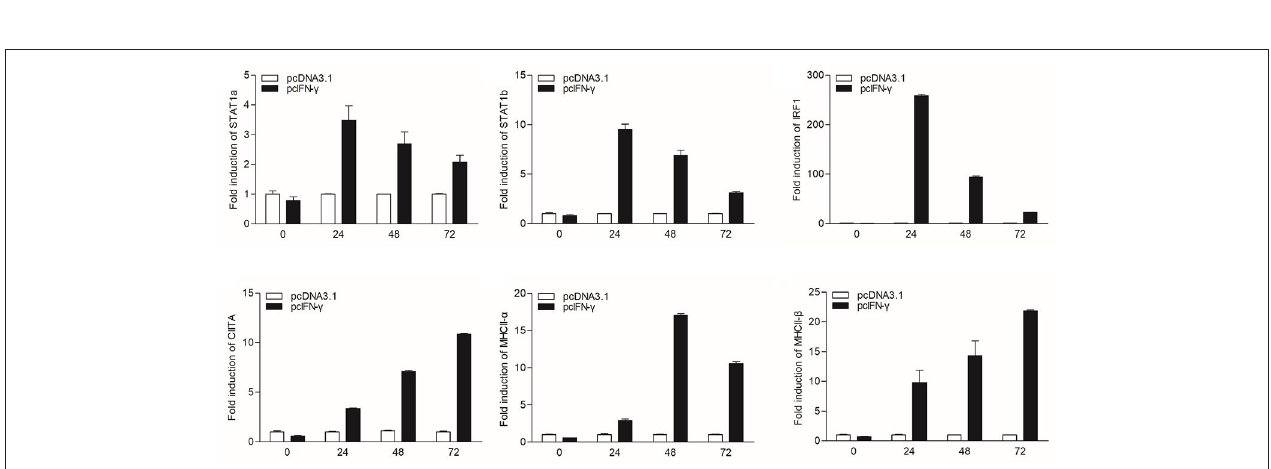
FIGURE 3 | mRNA expression of the STAT1a, STAT1b, IRF1, CIITA, and MHC II in vitro triggered by IFN- γ . GCO cells were transfected with 1.5 µ g pcDNA3.1 or pcIFN- γ respectively. Cells were harvested at 0, 24, 48 and 72h after transfection. Then total RNAs were extracted to examine the mRNA levels of STAT1a, STAT1b, IRF1, CIITA, and MHC II through